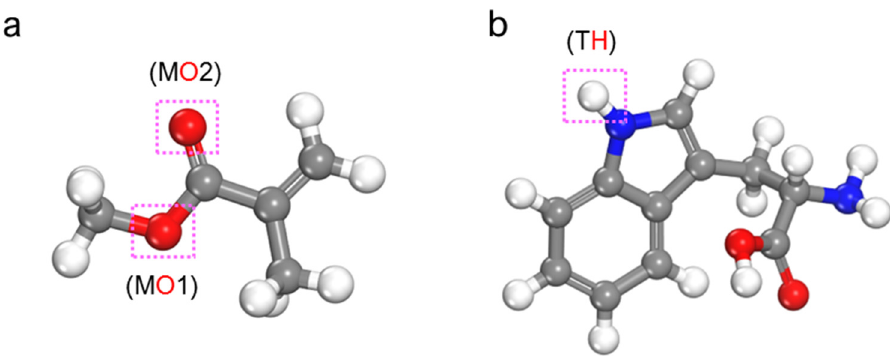
Figure 4. Chemical structures of ( a ) MMA and ( b ) tryptophan of CagA along with their labelled atoms for RDF analysis.